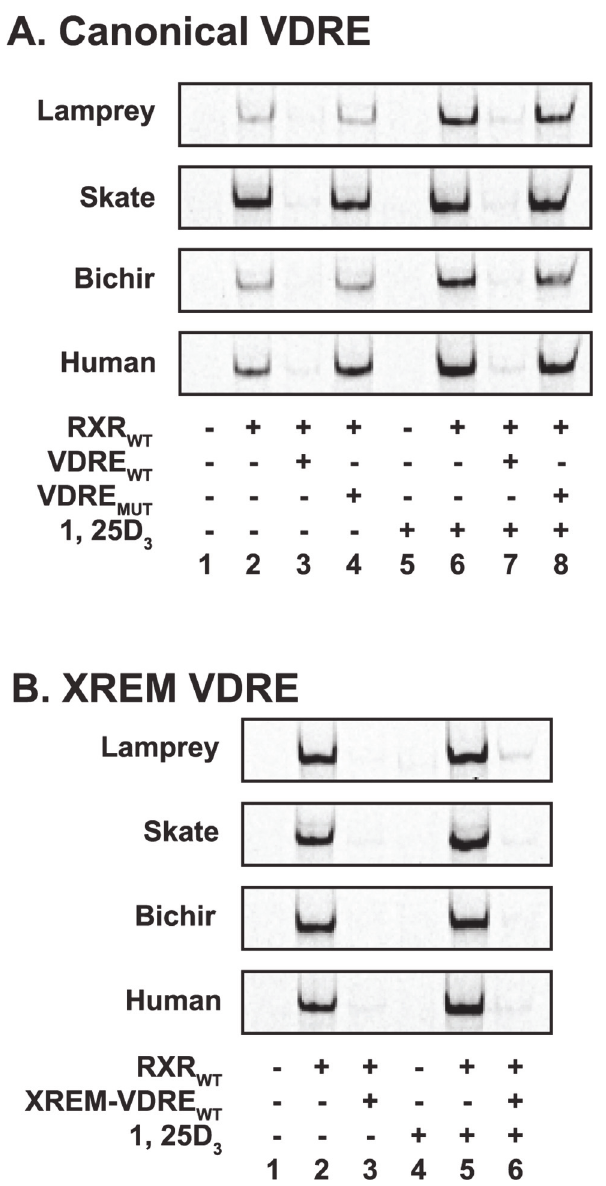
Fig 5. Electrophoretic mobility shift analysis of recombinant lamprey, skate, bichir, and human VDR. The above images depict VDR-RXR heterodimer binding to both (A) the canonical VDRE, and (B) the VDRE from the XREM region of CYP3A4. (A) With the canonical VDRE, DNA binding complexes were only observed in the presence of RXR WT (lanes 2, 4, 6, 8 vs. lanes 1, 3, 5, 7). The addition of 100 nM 1, 25D 3 (lanes 5 – 8) visibly enhanced binding complex formation compared to the ethanol control (lanes 1 – 4). In competition assays, the addition of 100-fold molar excess of the unlabeled wild type competitor (VDRE WT ) successfully outcompeted binding to the labeled VDRE (lanes 2 vs. 3 and 6 vs. 7). The use of the mutant competitor (VDRE MUT ) did not inhibit complex formation with any VDR tested (lanes 2 vs. 4 and 6 vs. 8). (B) A similar pattern was observed with the XREM VDRE. Complex formation was only observed in the presence of recombinant RXR WT (lanes 1 vs. 2 and 4 vs. 5). The addition of 100 nM 1, 25D 3 visibly enhanced complex formation (lane 2 vs. lane 5). In competition assays, the addition of 100-fold molar excess of the unlabeled XREM VDRE WT successfully outcompeted complex formation on the labeled XREM VDRE (lanes 2 vs. 3 and 5 vs. 6).